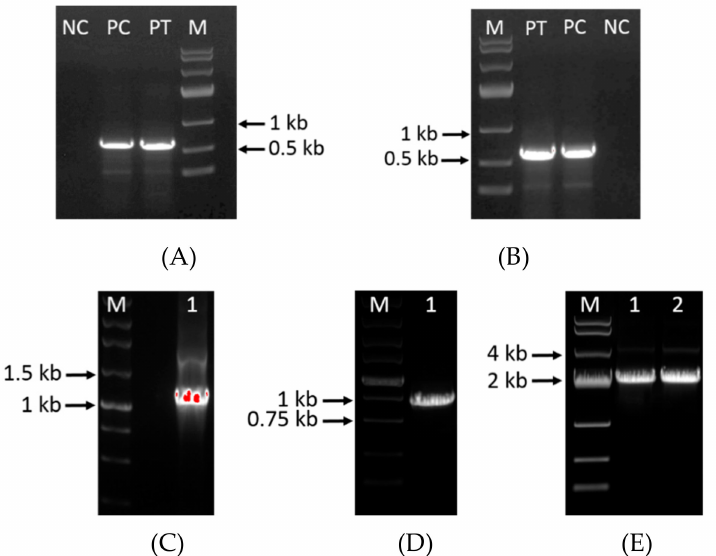
Figure 2. ( A ) Genomic PCR of partial zeocin expression cassette in the OrfB-ER disruption strain, ( B ) Genomic PCR of partial zeocin expression cassette in the OrfC-ER disruption strain. In the disruption strains, it should have an expected PCR product: Partial zeocin expression cassette (649 bp). PT: